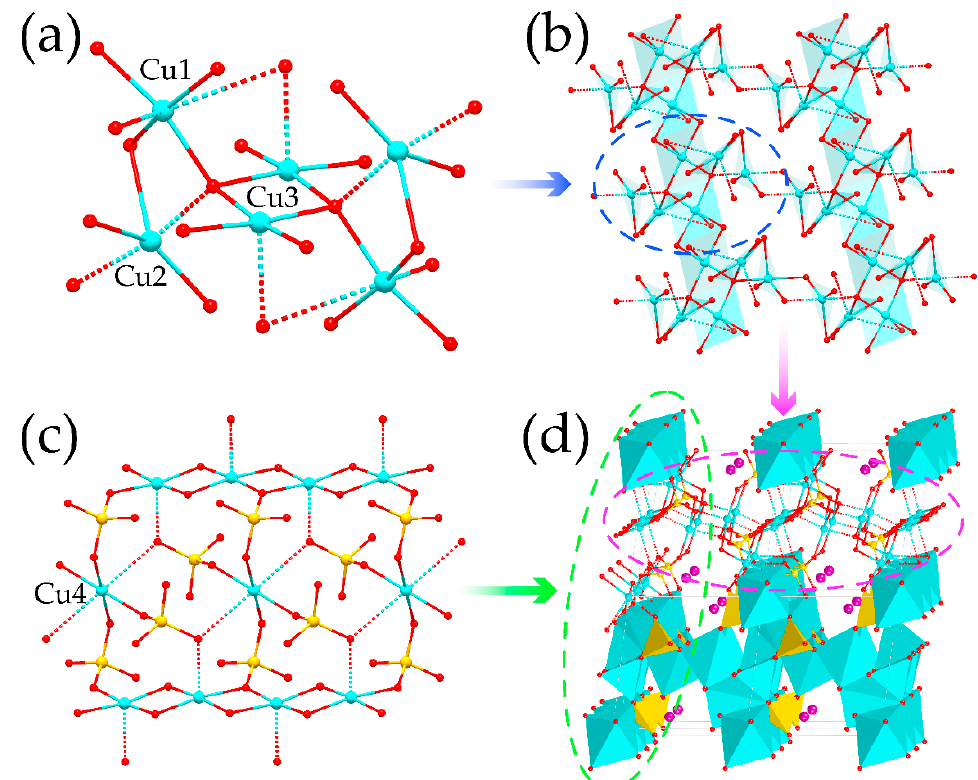
Figure 1. The key features of the crystal structure of 1 : ( a ) the linkage of coordination polyhedra of the Cu1, Cu2 and Cu3 atoms; ( b ) the Cu-based layer; ( c ) the rods of Cu3O 5 square pyramids and Cu4O 6 octahedra, connecting the Cu-based layers; ( d ) lateral view of the crystal structure. Legend: Cu = cyan, O = red, P = yellow, K = purple.